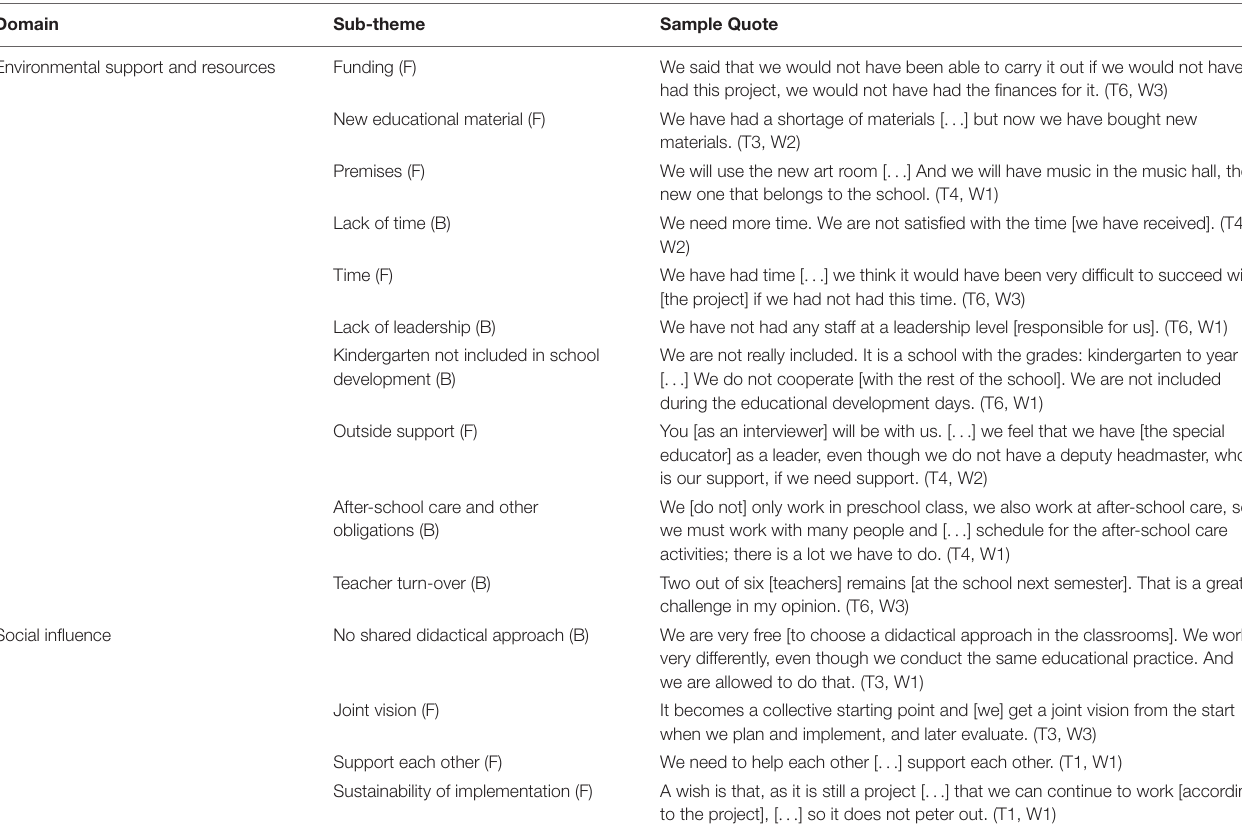
TABLE 2 | Opportunity.